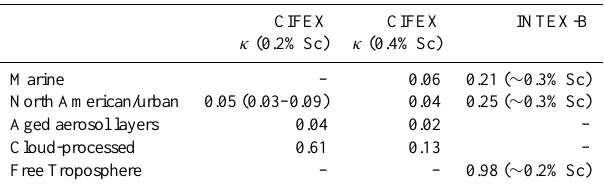
Table 5. κ values for different air masses during the CIFEX exper- iment (Roberts et al.,